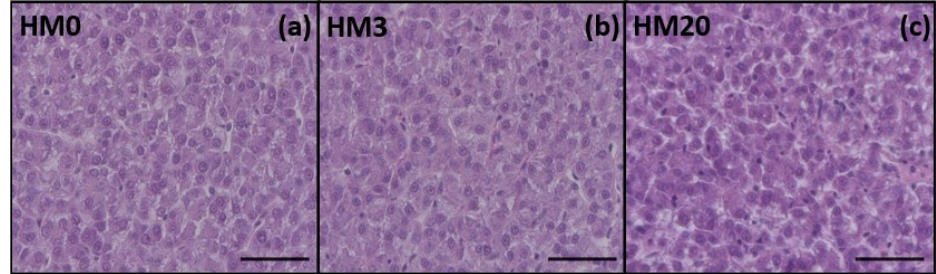
Figure 2. Representative histological images of liver parenchyma from rainbow trout fed experimental diets: ( a ) HM0, ( b ) HM3, and ( c ) HM20. Scale bars = 50 µ